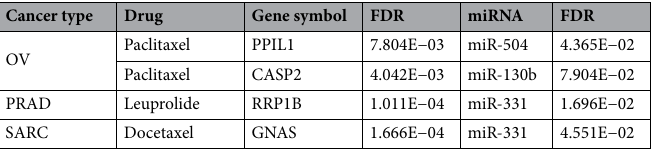
Table 2. Significant miRNA-cancer-drug combinations, and corresponding target genes that are also predictive of survival outcoms. This table represents the miRNA-mediated gene-cancer-drug combinations in all cancer-drug groups.